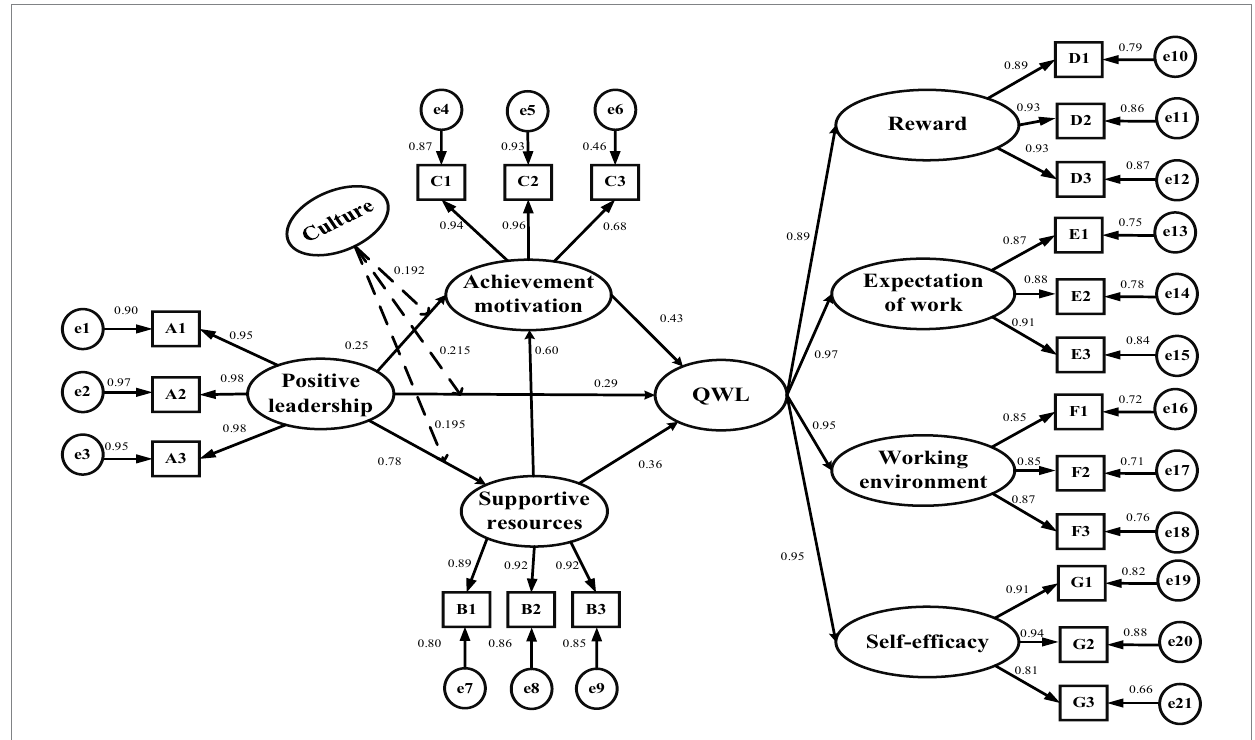
FIGURE 2 Model diagram of the influence of positive leadership promoting